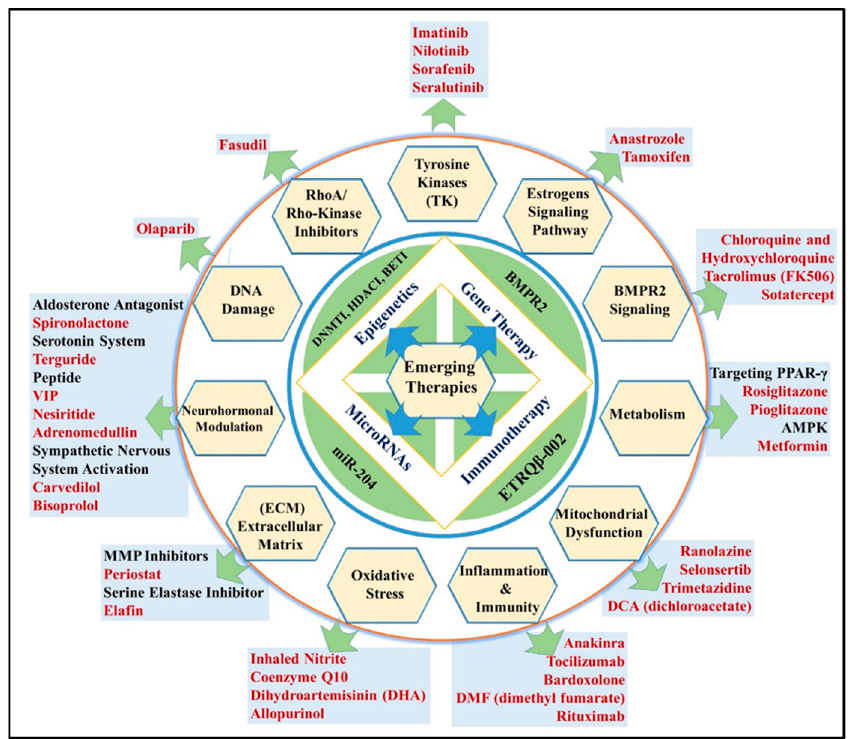
Figure 3. Molecules and pharmacological targets implicated in PAH (black fonts represent category of drugs; red fonts represent drug).